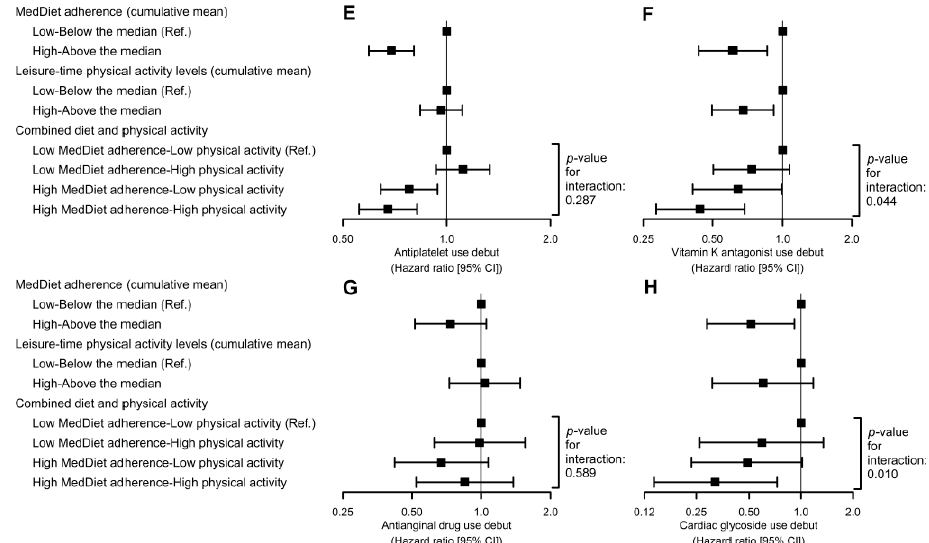
Figure 4. Combination of MedDiet adherence and leisure-time physical activity and the risk of initiating glucose-lowering ( A ), antihypertensive ( B ), statin ( C ), fibrate ( D ), antiplatelet ( E ), vitamin K epoxide reductase inhibitors ( F ), antianginal ( G ), and cardiac glycoside ( H ) therapies. Cox proportional hazards regression models were stratified by sex, recruitment site, and educational level, and adjusted for: age, diabetes, hypercholesterolemia, hypertriglyceridemia, hypertension, smoking habit, body mass index, alcohol consumption, energy intake, and PREDIMED intervention group. We substituted diabetes for fasting glucose in the analyses on glucose-lowering therapy initiation, hypertension for systolic blood pressure in the analyses on antihypertensive therapy initiation, hypercholesterolemia for total cholesterol in the analyses on statin initiation, and hypertriglyceridemia for triglycerides in the analyses on fibrate initiation. We used robust variance estimators to account for intra-cluster correlations .